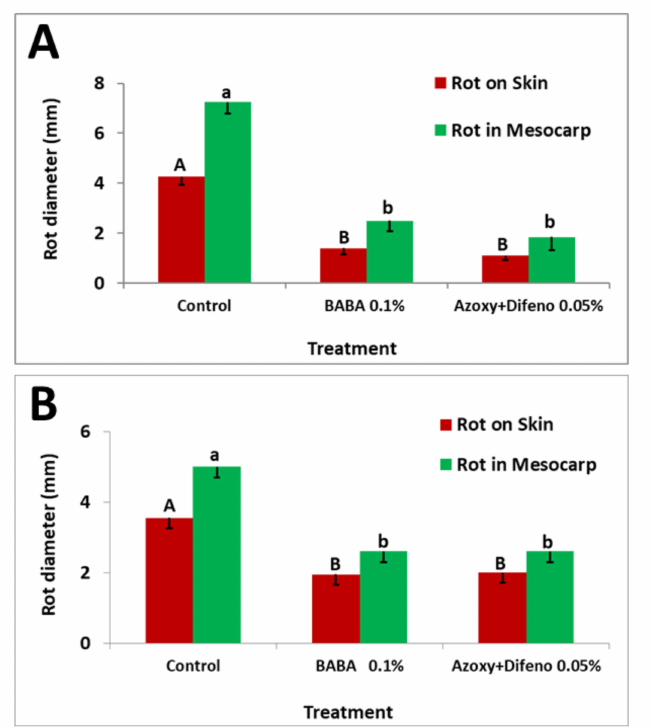
Figure 6. Efficacy of BABA and the pre-mixture azoxystrobin plus difenoconazole (Azoxy + Difeno) sprayed four days before inoculation on rot development in Pink Lady apple fruits in the orchard ( A ) Experiment 1. ( B ) Experiment 2. Mean values of lesion diameter on skin (uppercase letters) or in mesocarp (lowercase letters) above columns followed by different letters indicate significant ( p < 0.05) differences between treatments (Fisher’s LSD t -test). Bars represent the standard error of the mean.